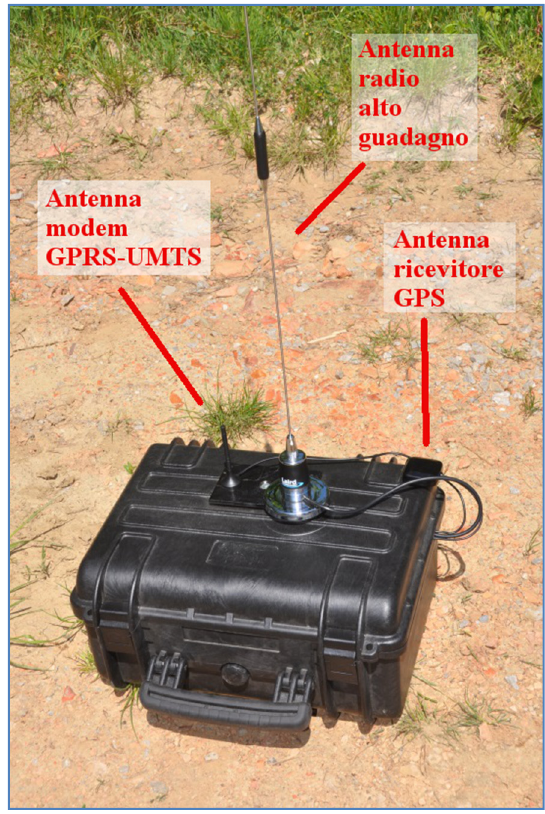
Figure 3. RTK ‐ Bridge device. Figure 3. RTK-Bridge